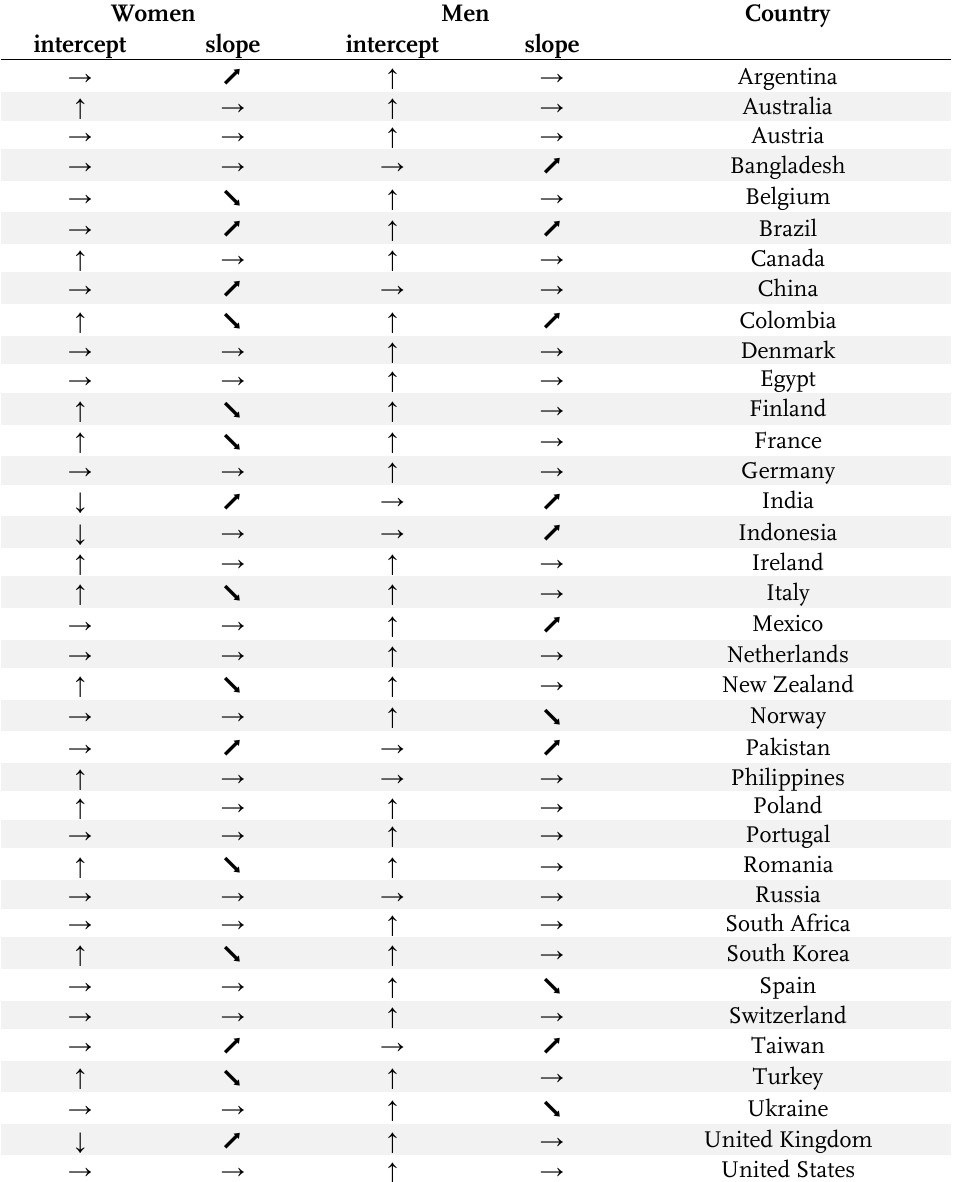
Table 3: Actual vs. predicted number of weekly contributions by country and